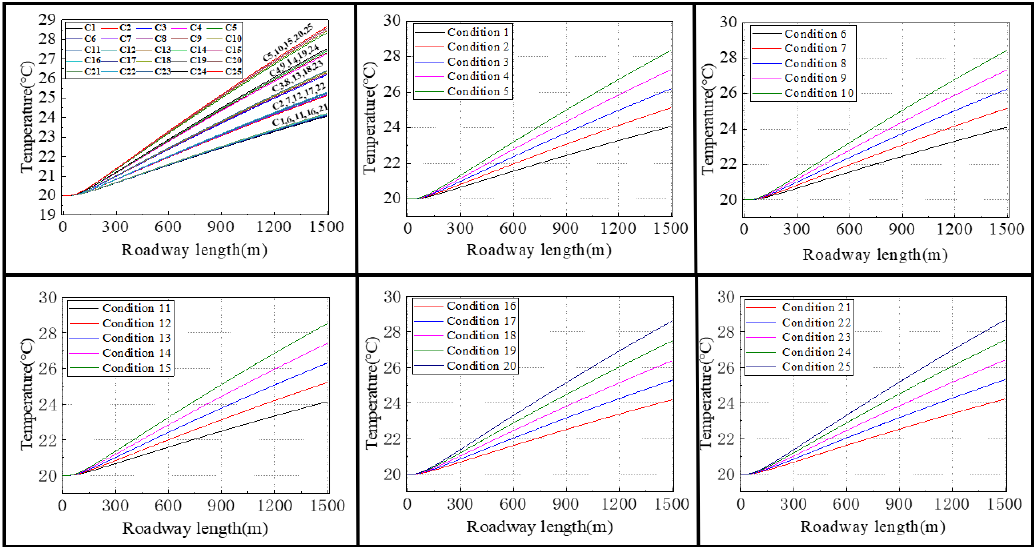
Figure 13. Airflow temperatures at various locations in the roadway at steady state for different upwelling water temperatures and the same upwelling water